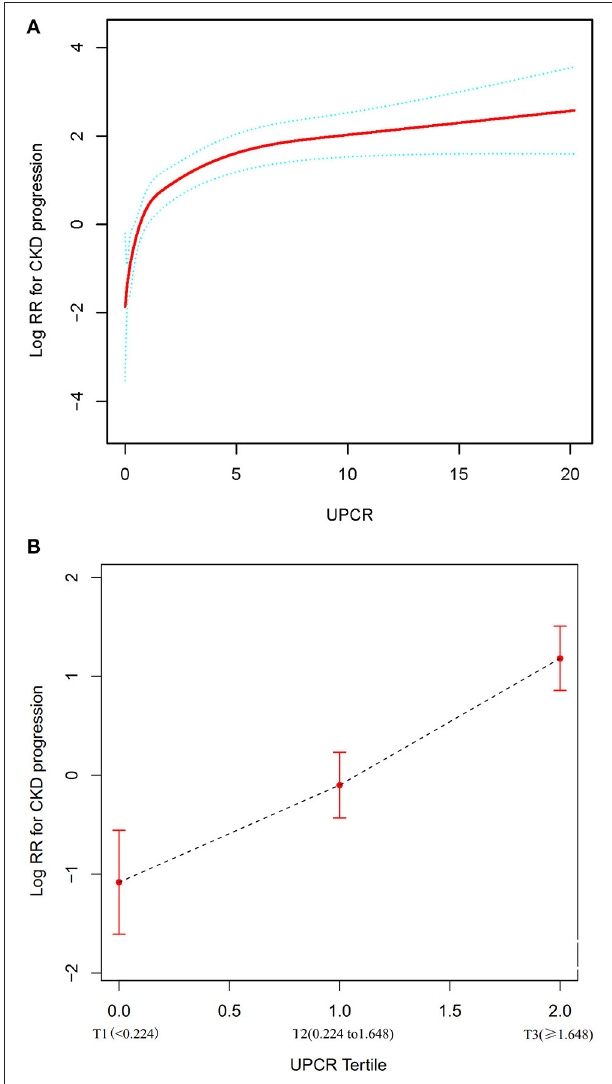
FIGURE 5 | The non-linear relationship between UPCR and CKD progression. (A) The non-linear relationship between UPCR (continuous variable) and CKD progression. (B) The non-linear relationship between UPCR (tertile variable) and CKD progression. We used a Cox proportional hazards regression model with cubic spline functions and smooth curve fitting (penalized spline method) to evaluate the relationship between UPCR and incident CKD progression. The result showed that the relationship between UPCR and CKD progression was non-linear after adjusting for age, gender, BMI, SBP, hypertension, diabetes, history of CVD, etiology of CKD, HB, eGFR, ALB, urinary occult blood, use of RAAS inhibitor, use of calcium channel blocker and use of diuretics.